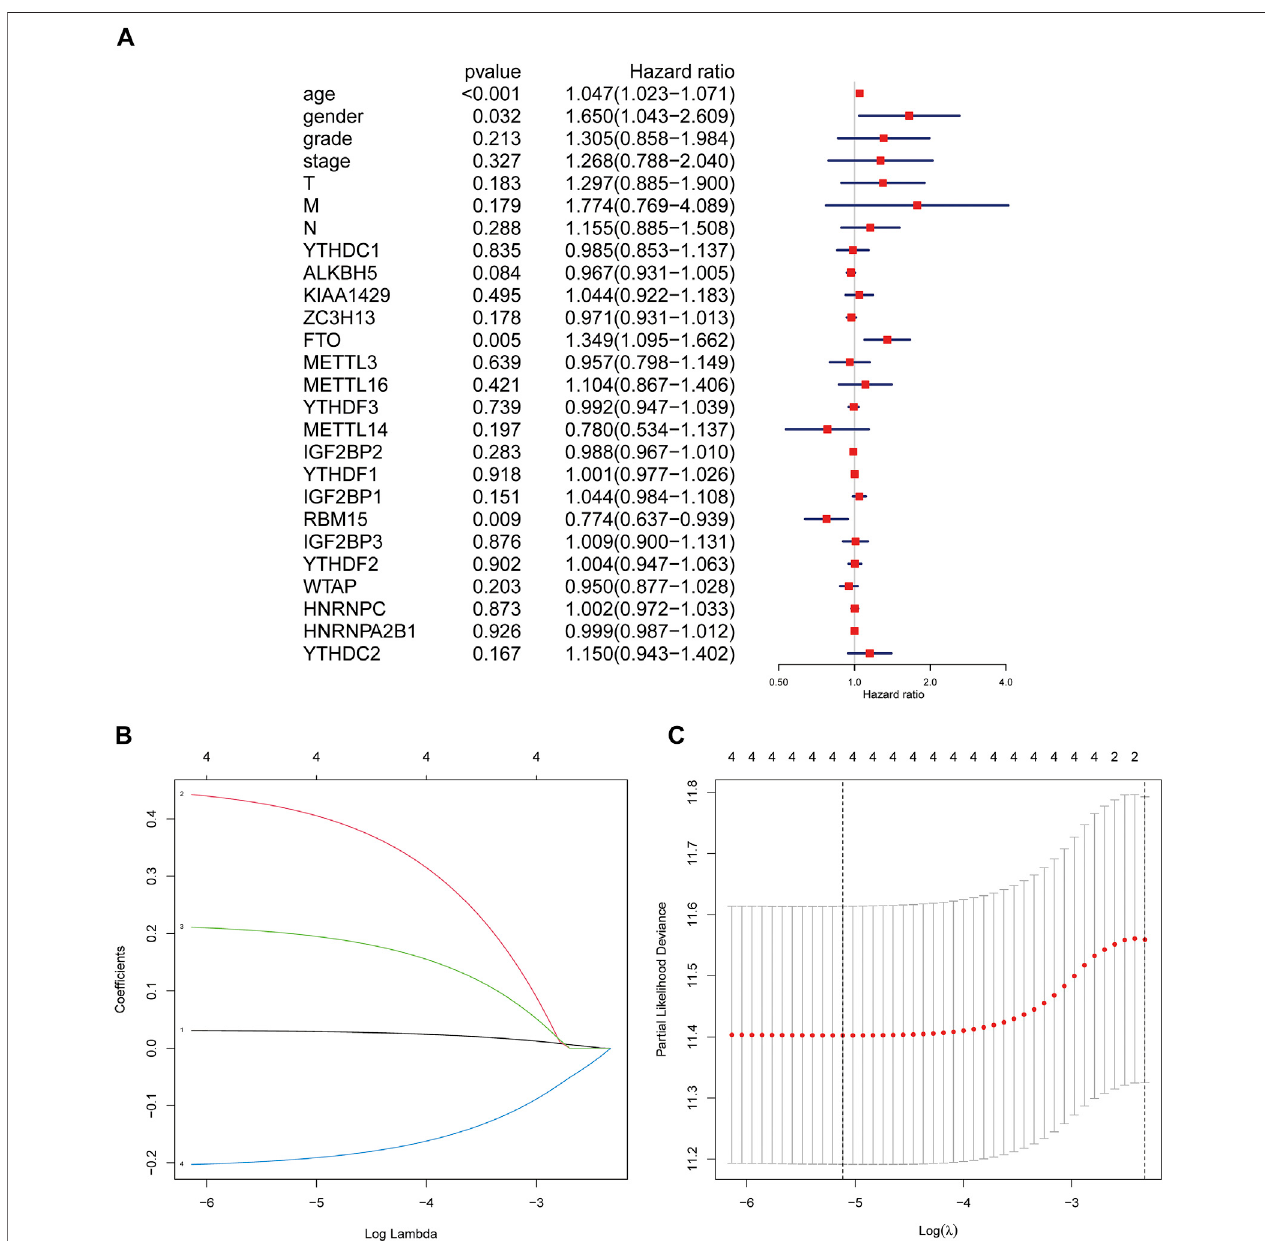
FIGURE 2 | Regression analysis of the relationship between clinical characteristics and m6A modi fi cation genes and prognosis of GC patients in the TCGA database. (A) MultivariateCoxregressionanalysisoftheprognosisinGCpatients. (B) LASSOcoef fi cientpro fi lesoftheexpressionof2m6Amodi fi cationgenesincluding FTO and RBM15 and two clinical characteristics including age and gender. (C) Selection of the penalty parameter ( λ ) in the LASSO Cox regression via 10-fold cross- validation. The dotted vertical lines are plotted at the optimal values following the minimum criteria (left) and “ one standard error ” criteria (right). GC, gastric cancer.